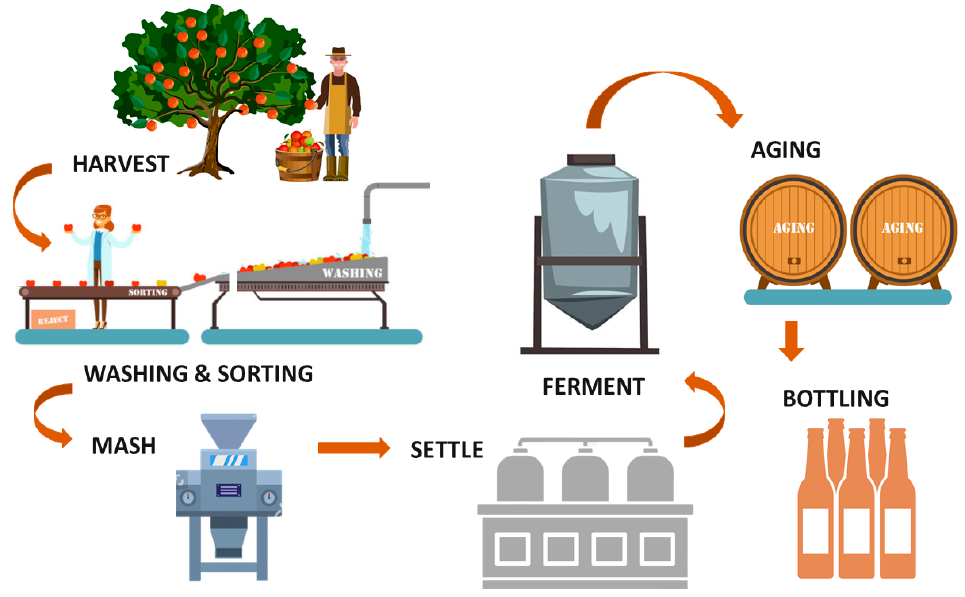
Figure 1. Main steps of the cider-making process.